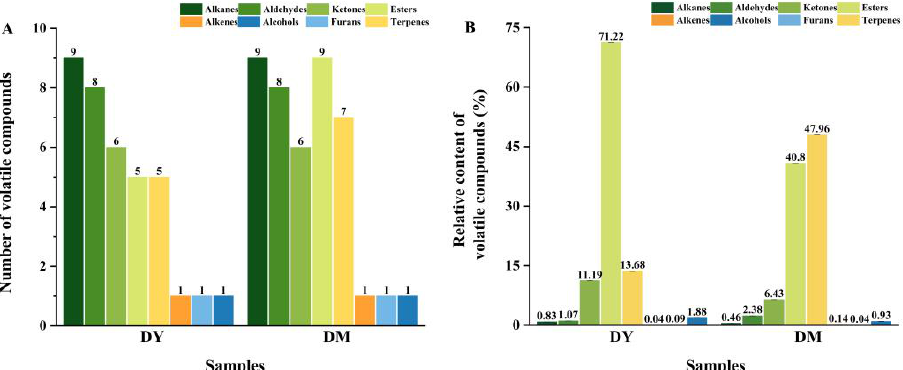
Figure 2. Comparing the volatile compounds in D. delavayi fruit of varying maturities. ( A ) Number of volatile compounds, and ( B ) relative content of volatile compounds.